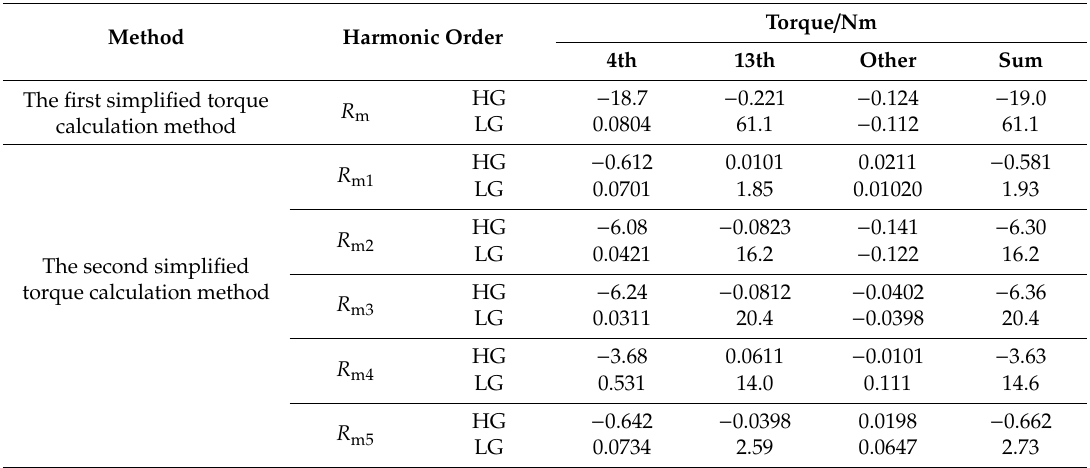
Table 4. Torque at di ff erent radii by the first or second simplified torque calculation method.